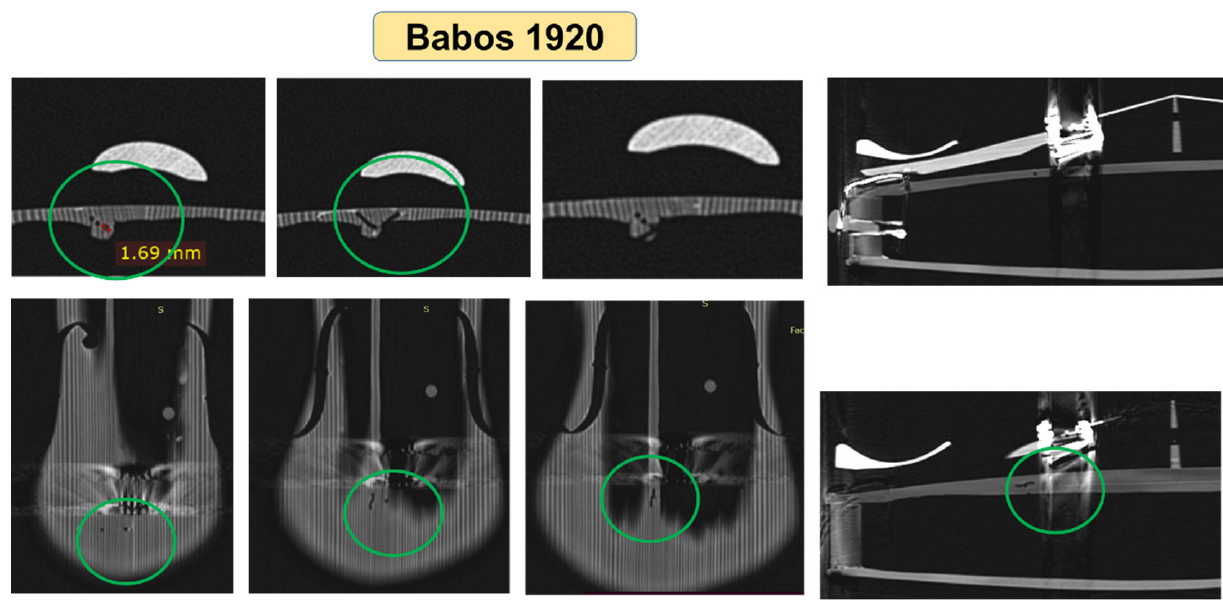
Figure 12. The trajectory of voids produced by coleoptera in case of the violin “Babos, 1920”.